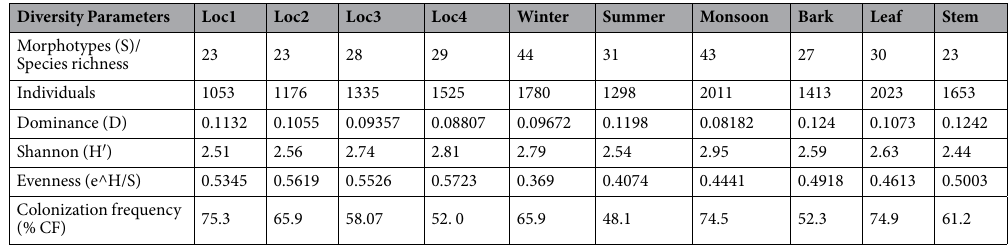
Table 4. Diversity parameters for aggregate data based on location, season and